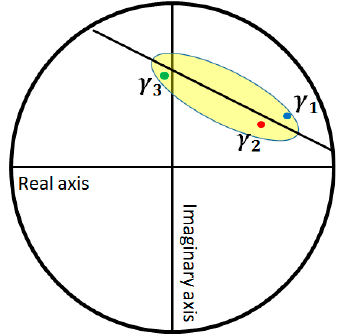
Figure 2. A schematic representation of the first step of the three-stage method: least-squared line fitting. The yellow region is the practical coherence region and γ 1 , γ 2 , and γ 3 are the selected complex coherence values for the line-fitting step.